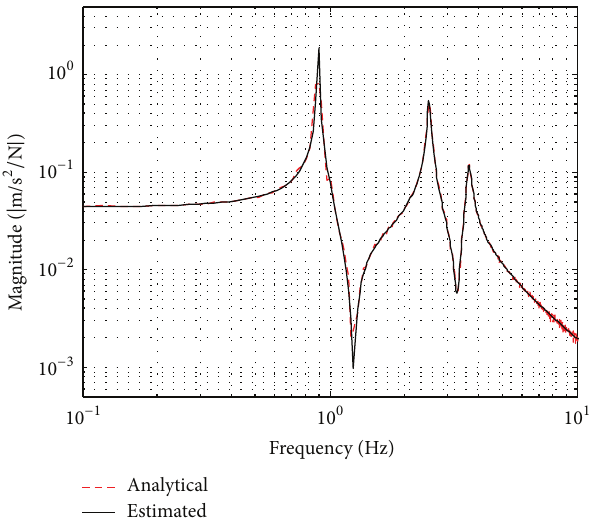
Table 7: Results of modal participation factor estimation.